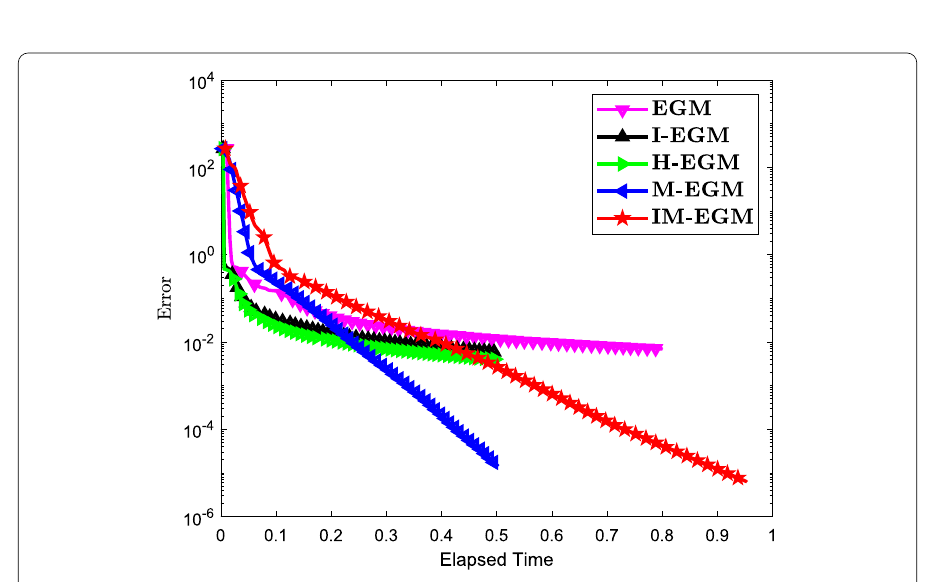
Figure 18 Numerical comparison of Algorithm 1 and Algorithm 2 using Algorithm 1 in [52], Algorithm 2 in [51], and Algorithm 1 in [18], while s 0 = s 1 = cos( t ) for the first 500